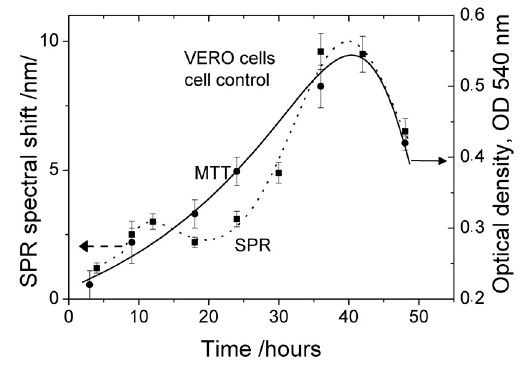
Figure 3. Growth kinetics of Vero cells: dotted line—SPR results (cell control); solid line—MTT re- sults.